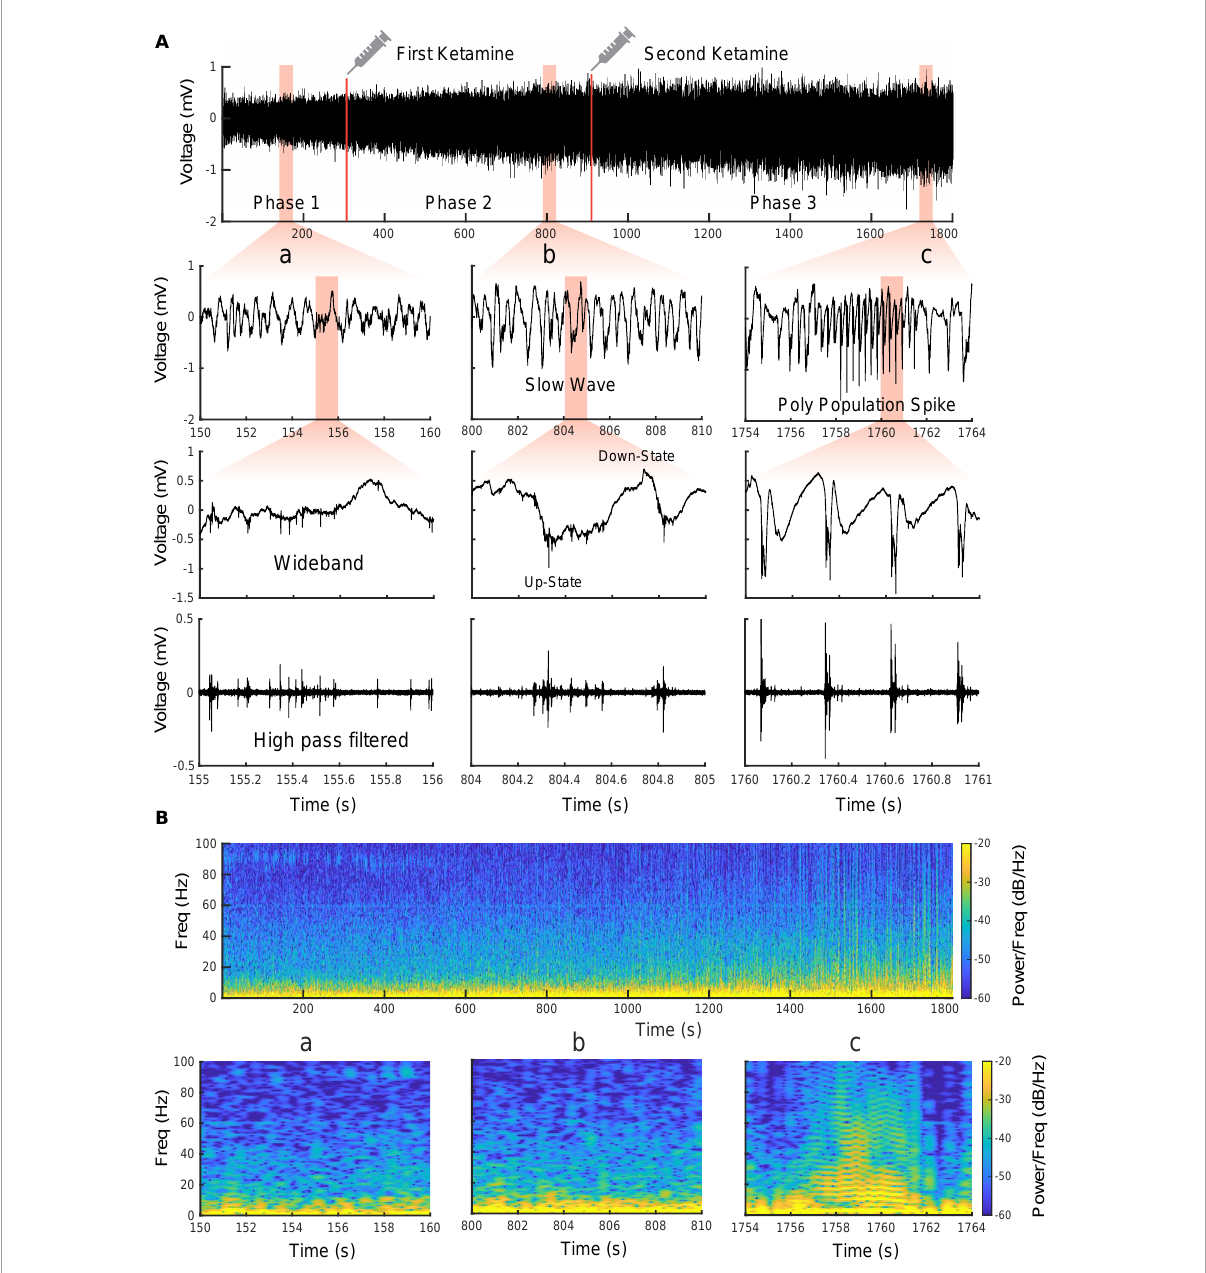
FIGURE4 Evolvement of sensorimotor cortical signals with ketamine injections. (A) Intracranial recording (S1, Rat11) are divided into three phases by two doses of ketamine. Representative data segments from the three phases are expanded to different timescales (a–c) . a Low-amplitude activity before the first additional dose of ketamine. b Slow-wave activity after the first additional dose of ketamine. c Poly population spikes (PPS) after the second additional dose of ketamine. These segments are further expanded and high pass filtered (250 Hz) to show the correlation between different states of LFP and neuronal spike firing (fourth row). (B) Spectrograms of the signals shown in (A)